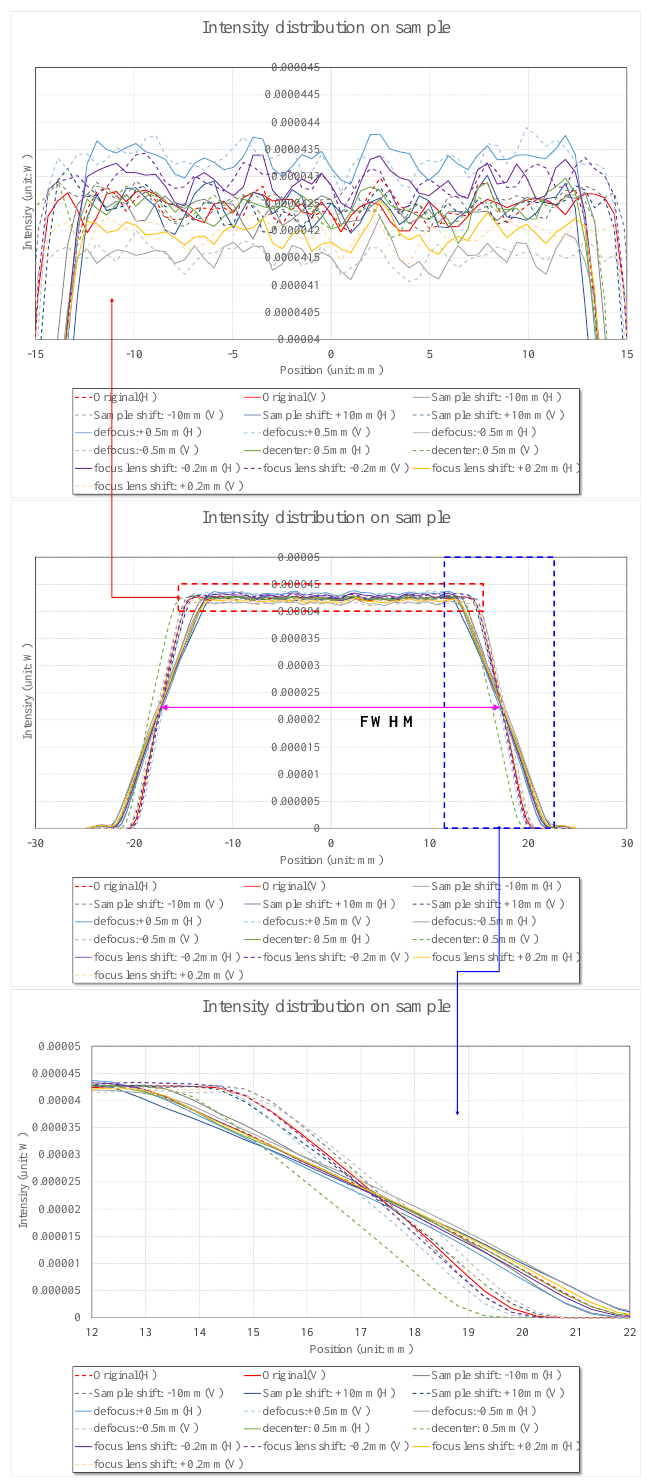
Figure 9. Intensity profile on sample by lens error.